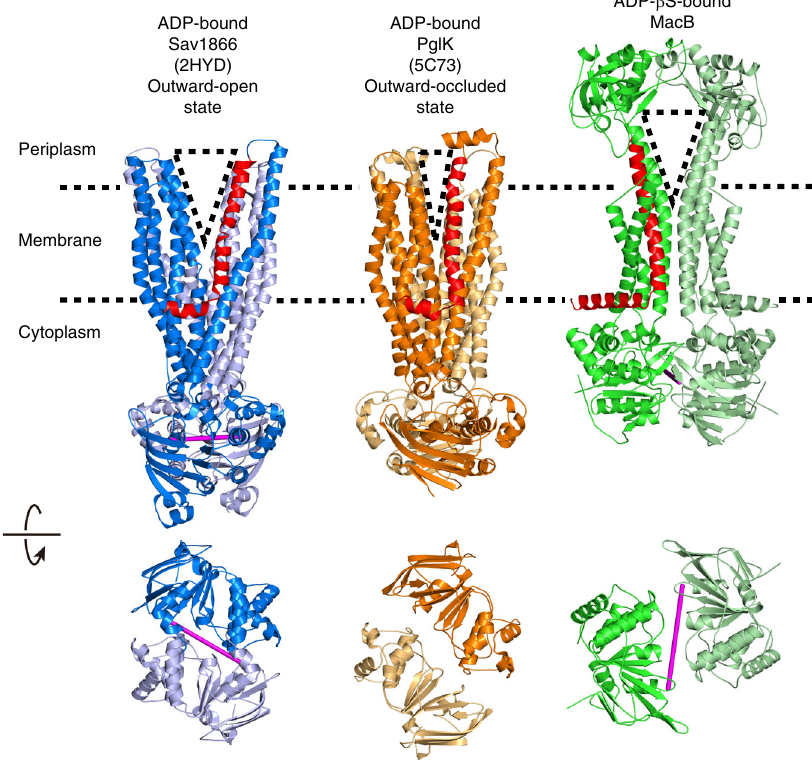
Fig. 6 Structural comparison between MacB vs. Sav1866 and PglK. Ribbon representation of (left) ADP-bound, outward-open conformation of Sav1866 (blue, PDB accession code: 2HYD) 9 , (middle) ADP bound, outward-occluded conformation of PglK (orange, PDB accession code:5C73) 25 and (right) ADP β S-bound MacB (green), viewed from membrane plane (top) and cytoplasm (bottom). Dotted lines depict the approximate membrane boundaries. Alfa phosphate atoms of the two bound nucleotides are connected by a magenta line showing the interface in each NBD dimer. For ADP-bound PglK, the coordinates of ADP were not deposited in the Protein Data Bank 25 . Outward-facing, V-shaped cavities in the TMDs are depicted as dotted triangles. Elbow helix and connecting TM1, which contribute to the extent of the external opening in each transporter, are coloured in